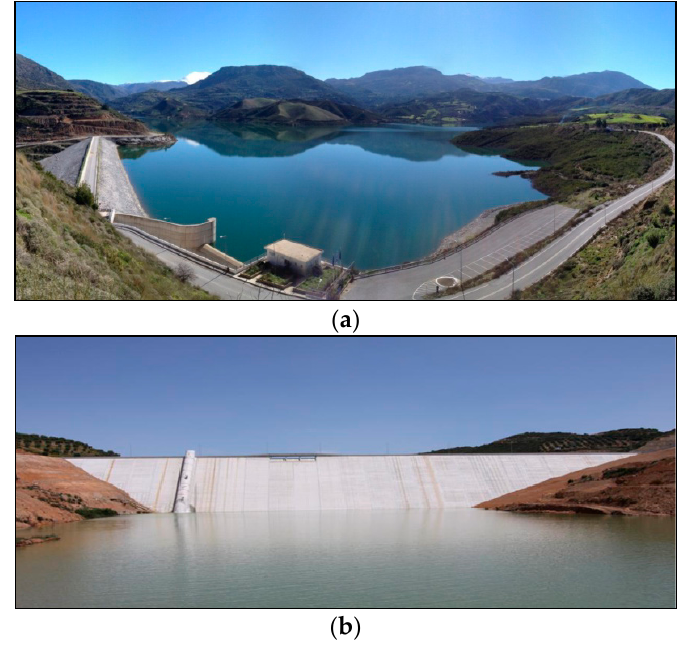
Figure 7. New dams: ( a ) Potamon (built in 2008); and ( b ) Valsamoti (built in 2014).